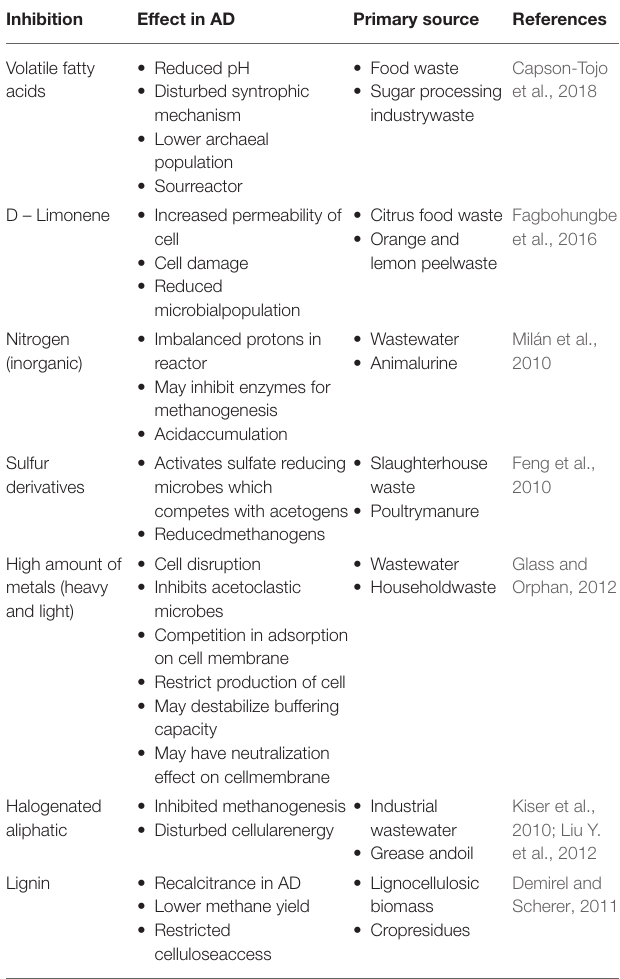
TABLE 1 | Inhibition in anaerobic digestion their